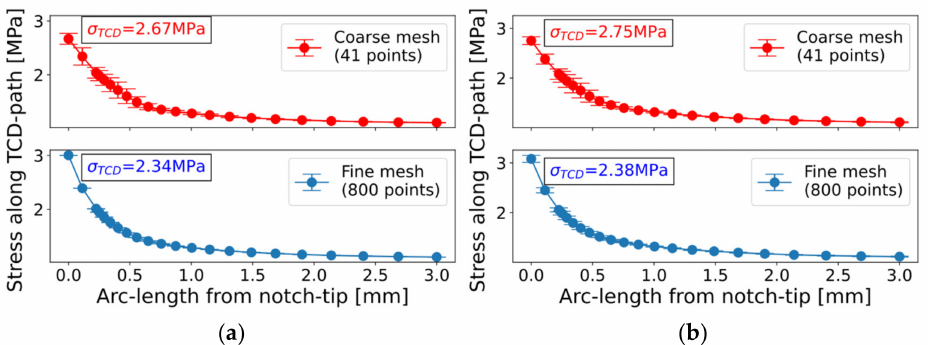
Figure 19. Evaluation of maximum TCD Point Method stresses of a circular hole-in-plate model with increasing arc-lengths and incremental load step of ∆ ϕ = 3 ◦ : ( a ) Sub-case method; and ( b ) Superposi- tion method.